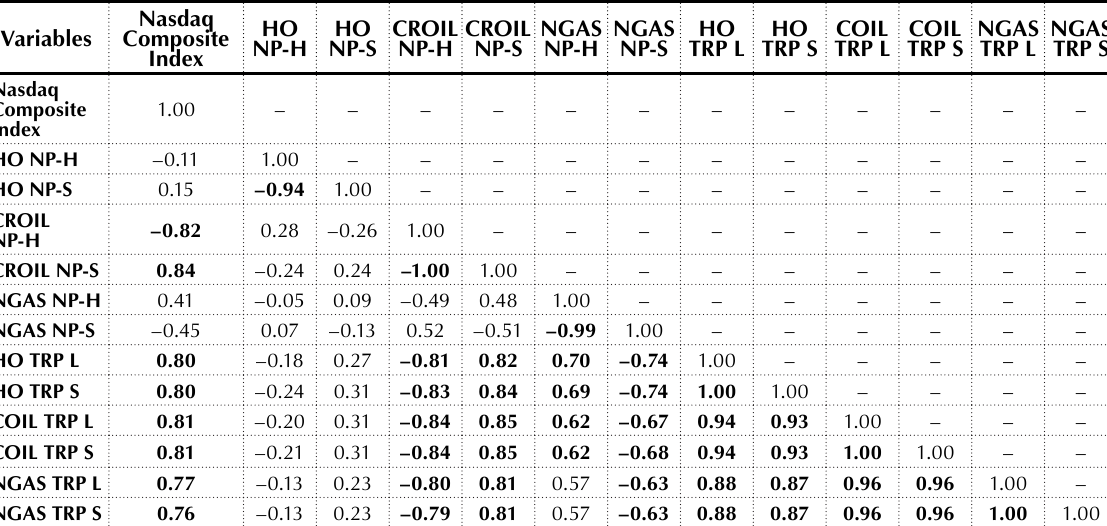
Table 2. Correlation among heating oil, natural gas and crude oil net